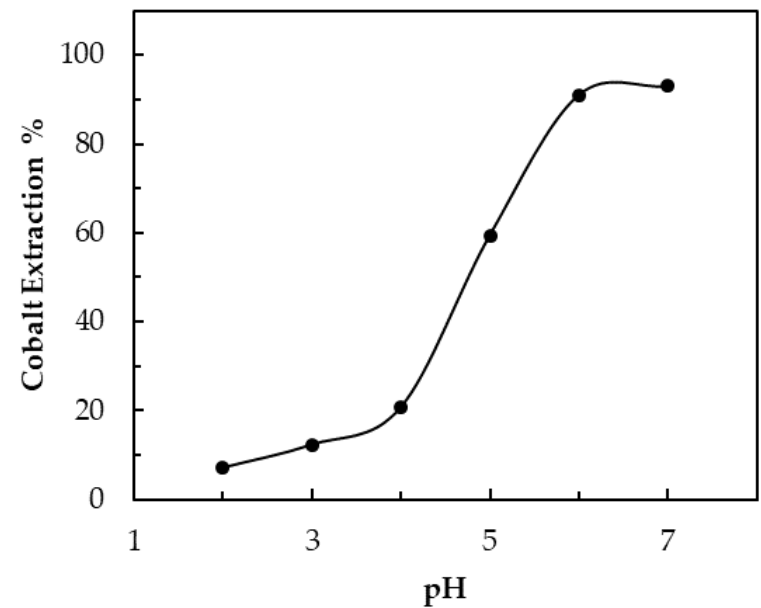
Figure 7. Effect of pH on extraction: aqueous-to-organic-phase ratio (A/O) = 1, initial concentration of aqueous phase (Xi) = 12 g/L, [Cyanex 272] = 0.4 mol/L, time = 12 min, and temperature = 22 ± 1 °C.